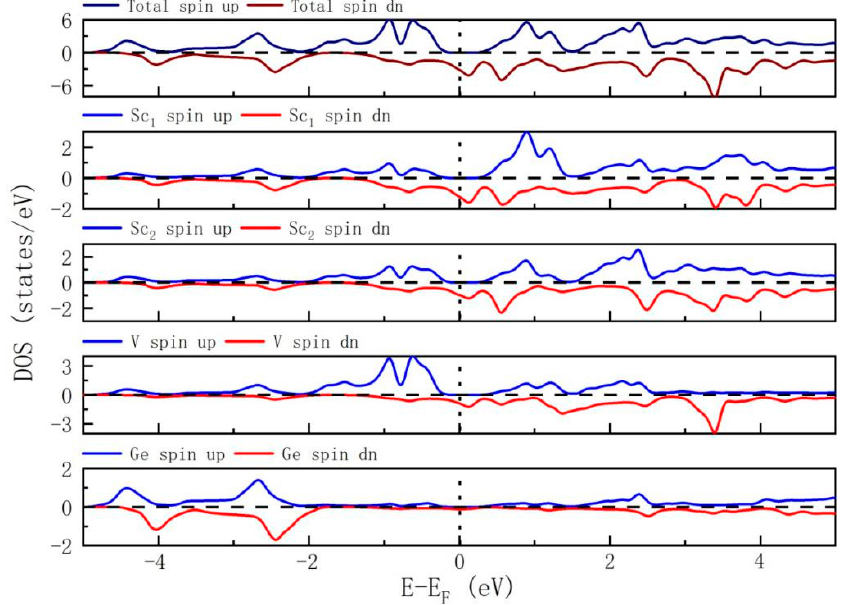
Figure 4. density of states (TDOS) and partial density of states (PDOS) for XA-type Sc 2 VGe. Figure 4. Density of states (TDOS) and partial density of states (PDOS) for XA-type Sc 2